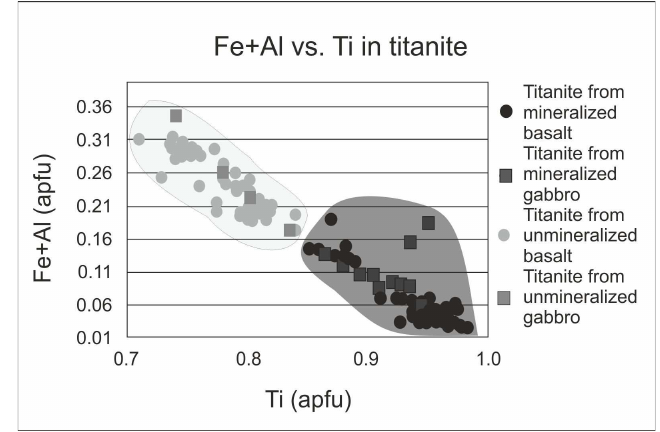
Figure 4. Fe + Al vs. Ti content of titanite from mineralized and unmineralized zones. Distinct fields